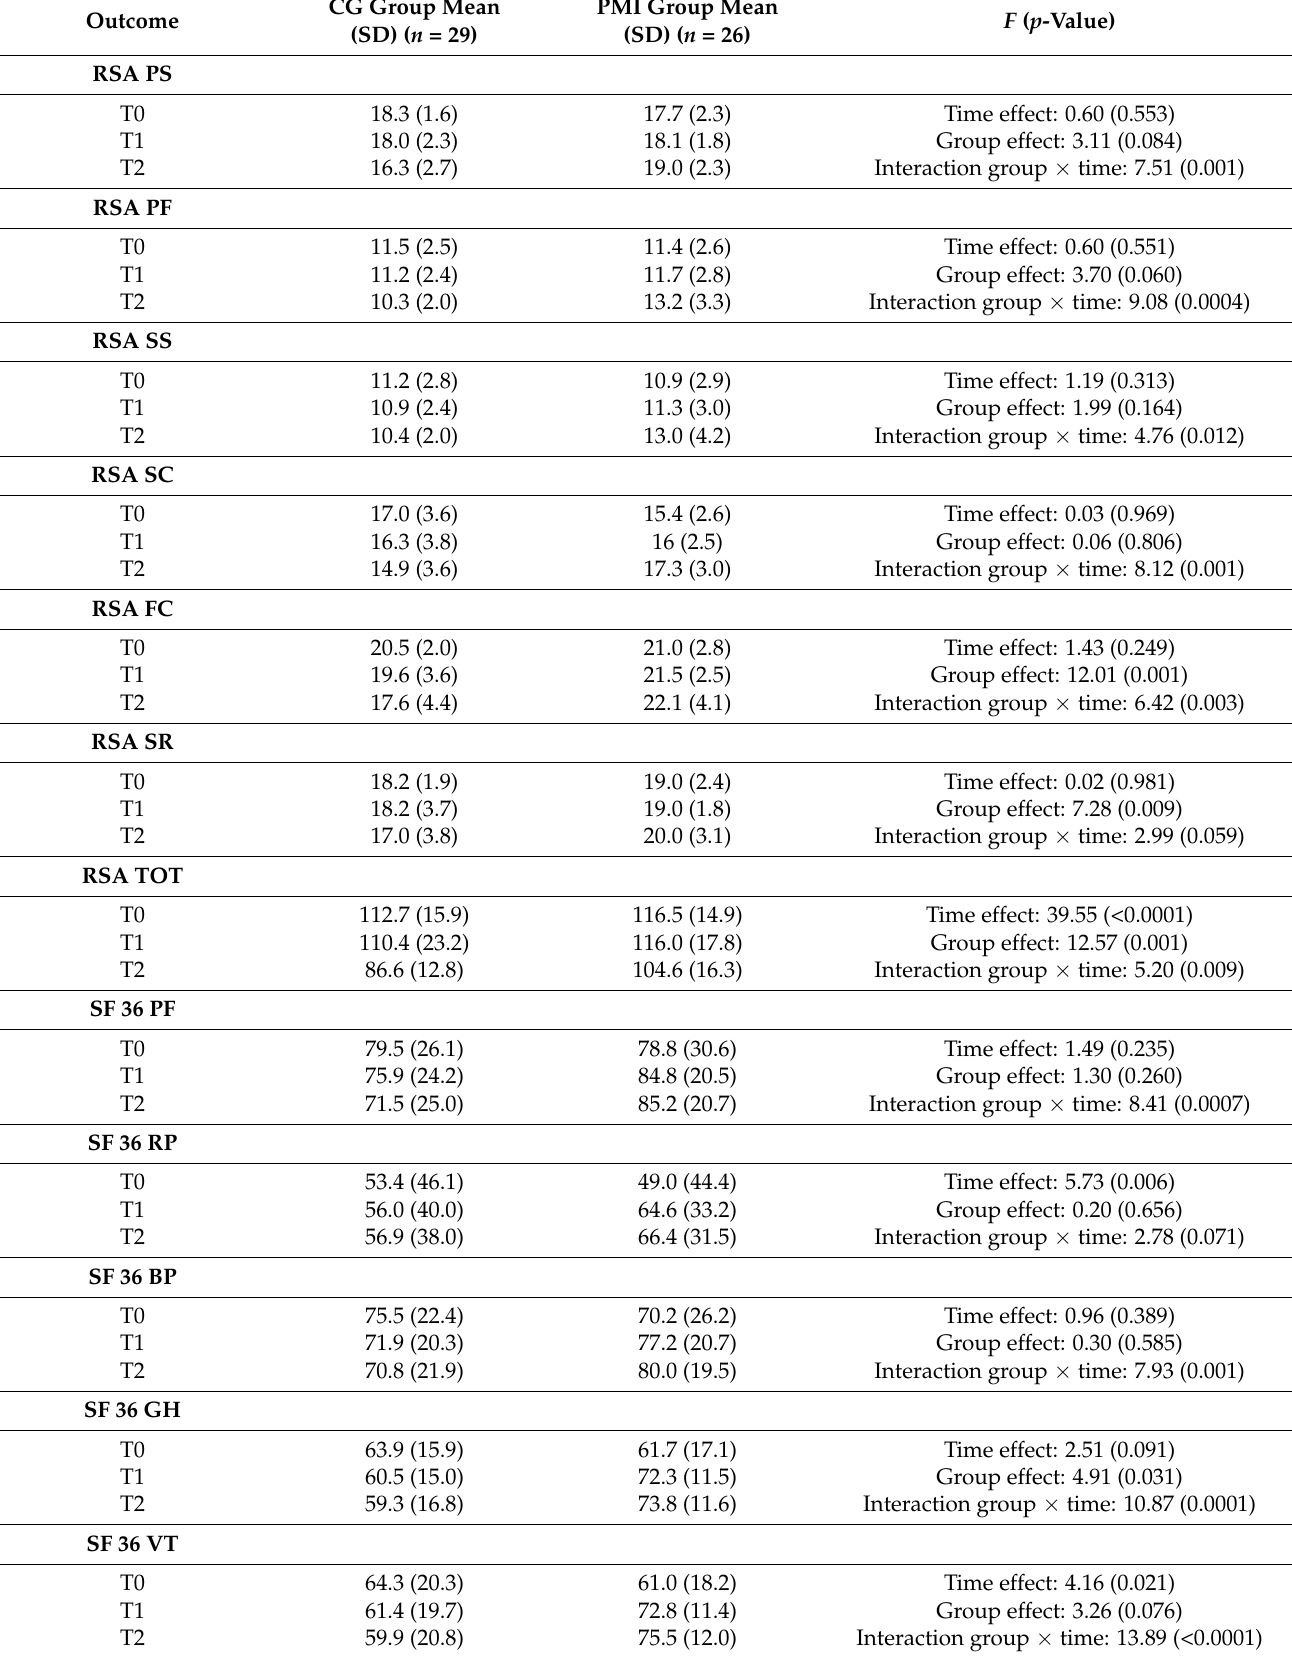
Table 4. Exploratory secondary outcomes: resilience (RSA), quality of life (SF), inflammatory markers, and biochemical